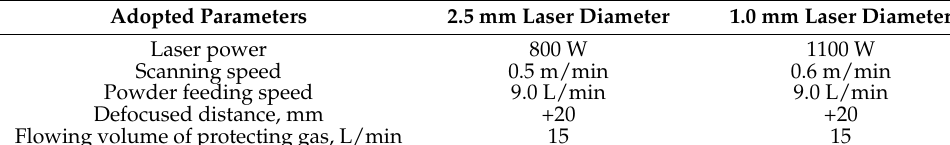
Figure 3. Repairing needed for TC4 and repairing paths: ( a ) Hole in TC4 matrix, ( b ) Laser-repairing paths. Table 2. Detailed process parameters employed in this research.